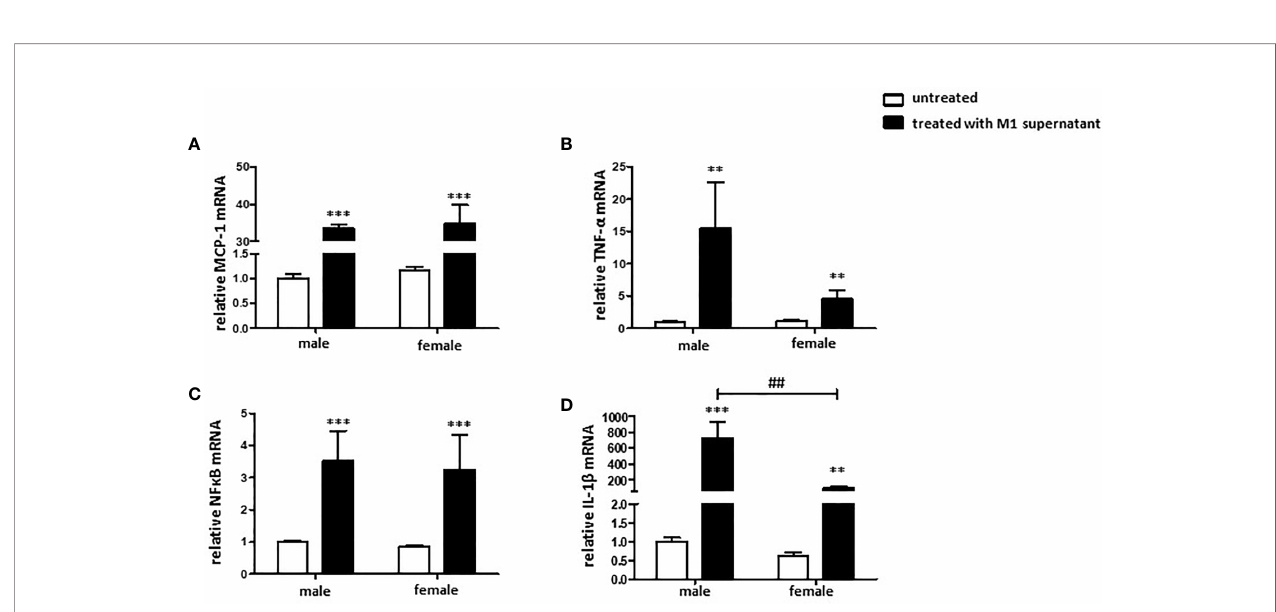
FIGURE 6 | Pro-in fl ammatory environment promotes a pro-in fl ammatory and pro- fi brotic fi broblast phenotype. Real-time PCR analyses of (A) MCP-1, (B) TNF- a , (C) NF k B, and (D) IL-1 b performed with lysates from male and female mice cardiac fi broblasts cultivated with conditioned medium from M1 polarized BMMs for 24 h. Data are shown as means ± SEM (n = 6; independent experiments with technical duplicates). Data are normalized to the male untreated group. **p < 0.01, ***p < 0.001, untreated vs. treated; ## p < 0.01, male vs.